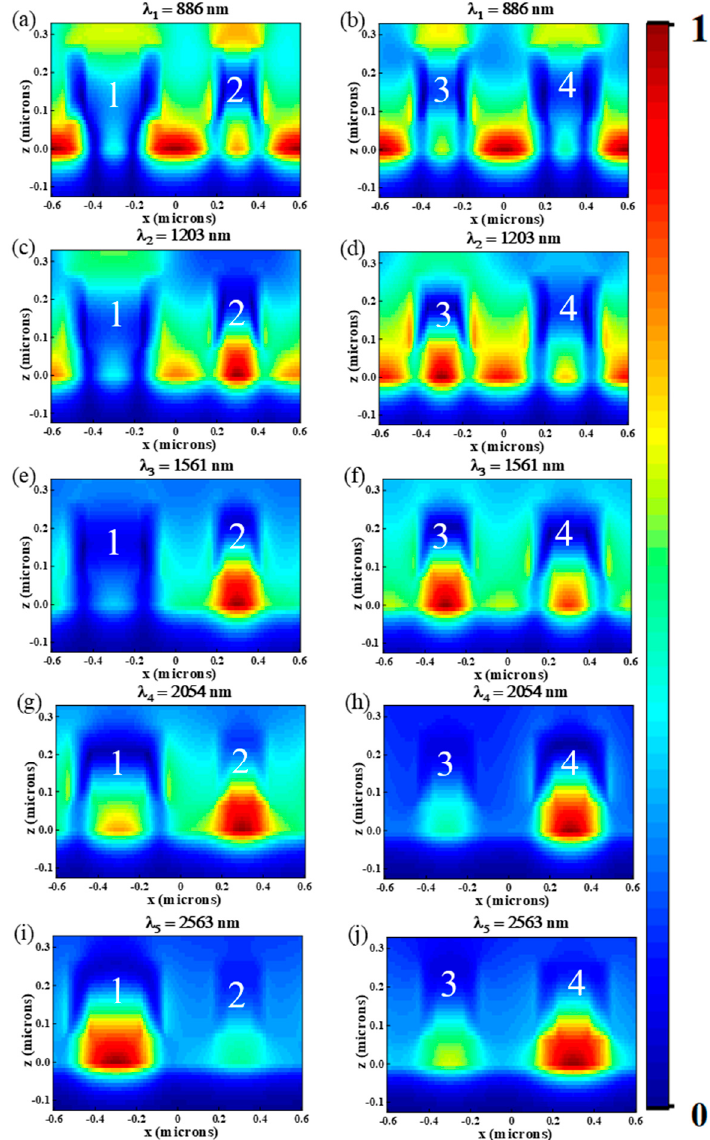
Figure 5. In the x – y plane, the magnetic field distribution of the absorber at ( a , b ) λ 1 = 886 nm, Figure 5. In the x − y plane, the magnetic field distribution of the absorber at ( a ) λ 1 = 886 nm, ( b ) λ 2 = 1204 nm, ( c ) λ 3 = 1561 nm, ( d ) λ 4 = 2054 nm, ( e ) λ 5 = 2563 nm. ( c , d ) λ 2 = 1204 nm, ( e , f ) λ 3 = 1561 nm, ( g , h ) λ 4 = 2054 nm, ( i , j ) λ 5 = 2563